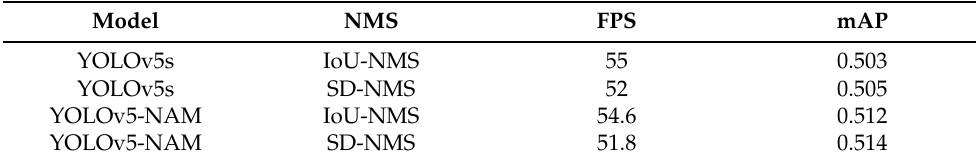
Table 3. The influence of NMS method.